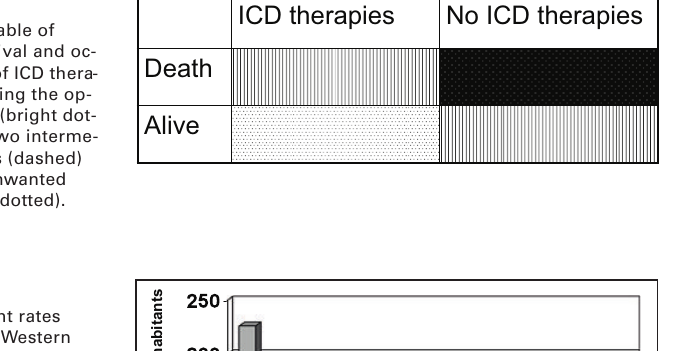
ICD implant rates in various